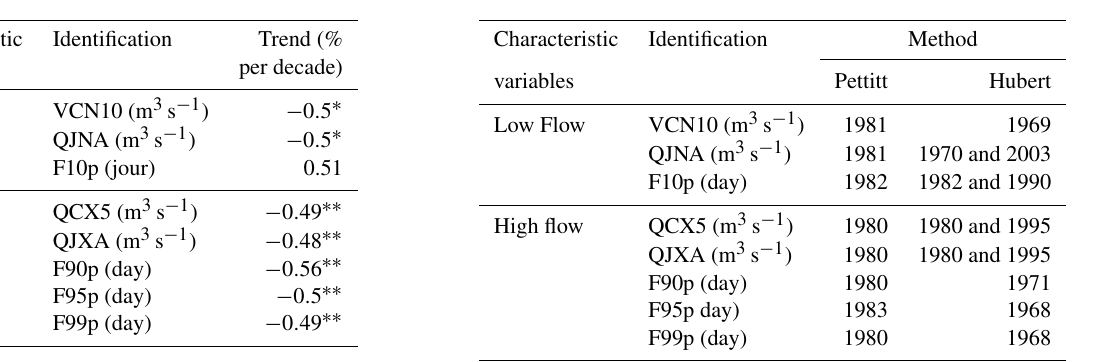
Table 5. Stationarity of low flow and high flow